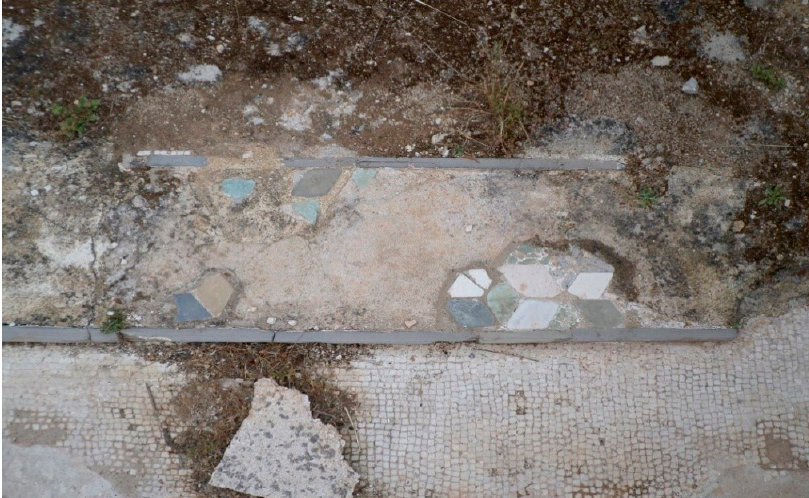
Figure 6. Soluntum, House of Leda, room d’s limestone threshold (photo by the author).